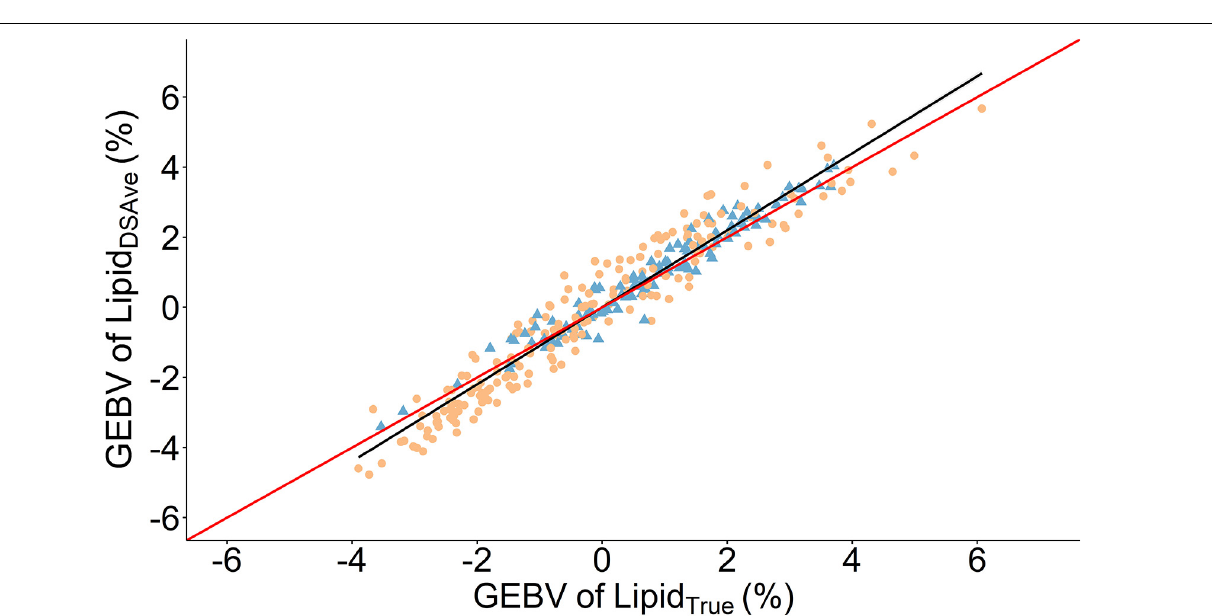
Genetic parameters 1